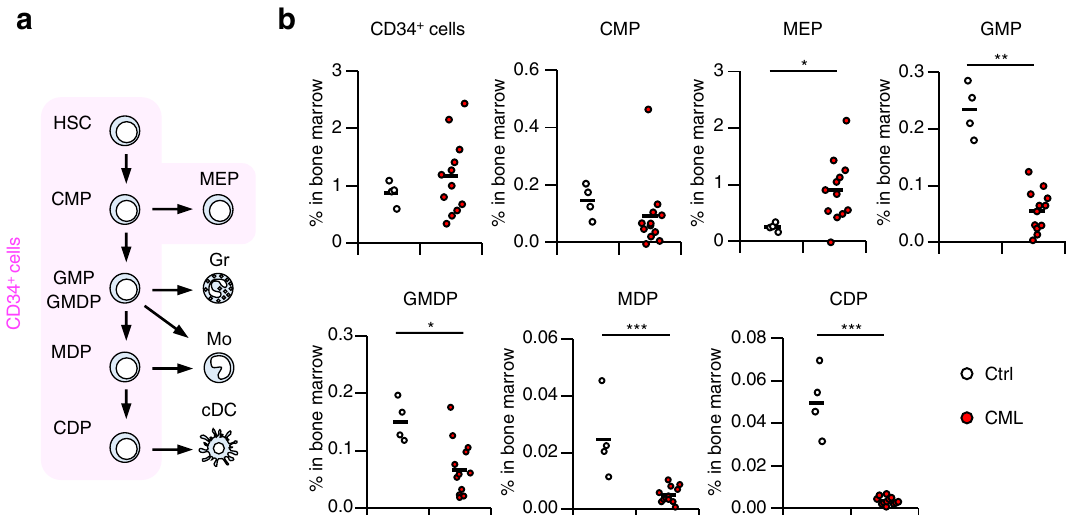
Figure 2. Proportion of myeloid progenitors in CML patients. ( a ) Schematic diagram of myeloid cell development. HSC hematopoietic stem cells, CMP common myeloid progenitors, MEP megakaryocyte erythroid progenitors, GMP granulocyte monocyte progenitors, GMDP granulocyte monocyte DC progenitors, MDP monocyte DC progenitors, CDP common dendritic cell progenitors; Gr granulocytes, Mo monocytes; cDC conventional dendritic cells including cDC1 and cDC2. ( b ) Proportion of bone marrow myeloid progenitors in CML patients (Normal controls [Ctrl], n = 4; CML patients [CML], n = 12). The horizontal lines indicate mean values. * P < 0.05, ** P < 0.01, *** P < 0.001 (Student’s t -test).